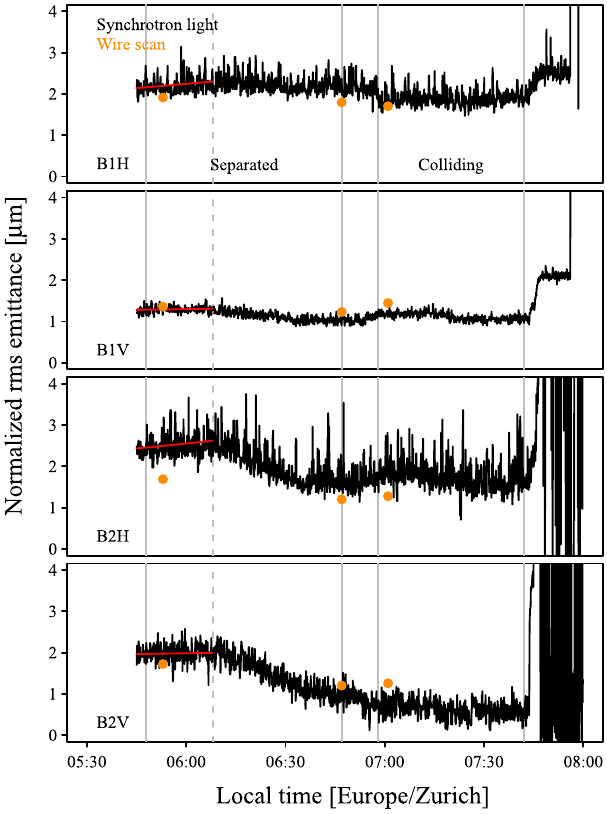
FIG. 10. Synchrotron-light and wire-scan emittances over the course of the